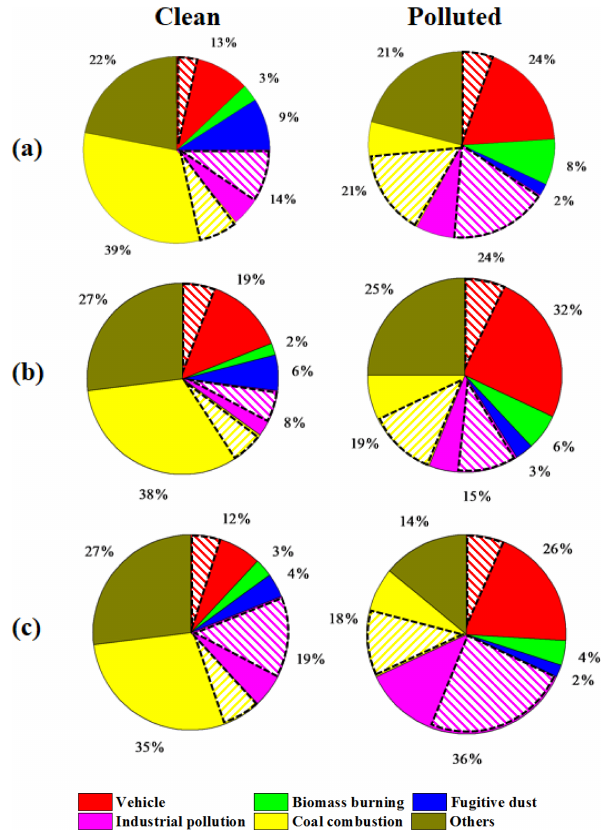
Figure 8. Source apportionment of light scattering for accumula- tion mode particles for the clean and polluted periods at NJU (a) , PAES (b) and NUIST (c) . The shadow represents the contribution of secondary aerosols from each source